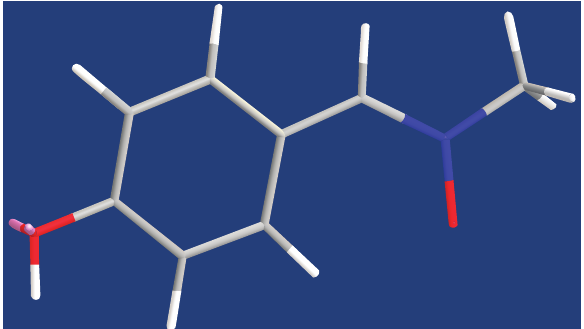
Figure 5: The steady conformation of PN4.